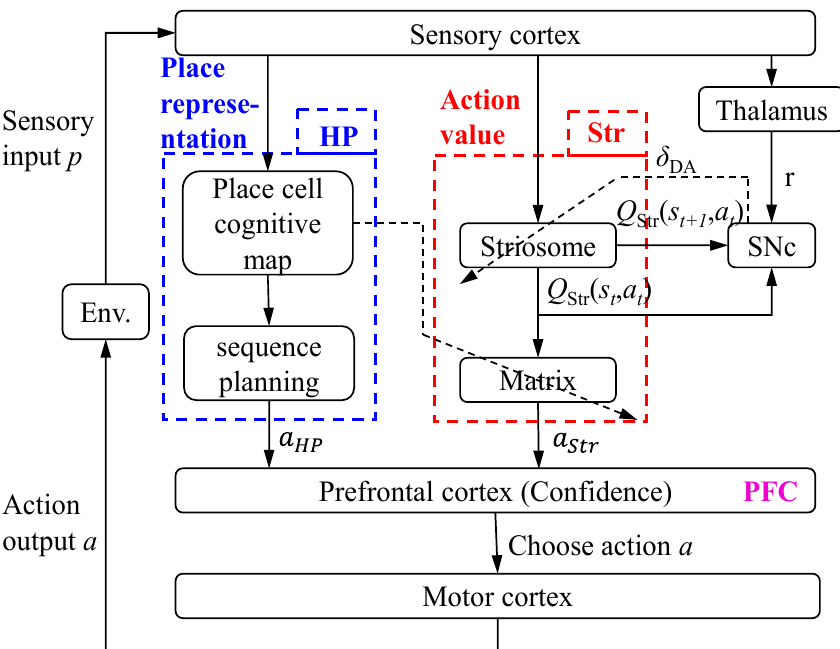
Figure 2. NLM-HS architecture. HP: hippocampus, Str: striatum, PFC: prefrontal cortex, SNc: substantia nigra pars compacta. In the NLM-HS, the functionality of the hippocampal–striatal circuit is designed as follows: The hippocampal model generates a cognitive map of the environment and performs goal-directed navigation. The striatal model performs reward-related habitual navigation. Since the two models may produce inconsistent behavioral decisions, the prefrontal cortex model chooses the most appropriate strategies according to “confidence”. The agent performs the chosen action and gets a new perception, completing an interaction with the environment.